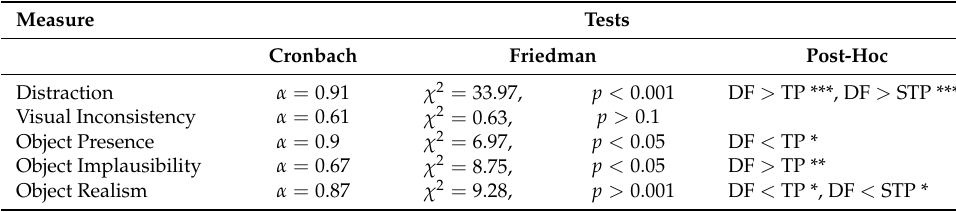
Table 1. Experimental results of [7] (* p < 0.05; ** p < 0.01; *** p < 0.001).